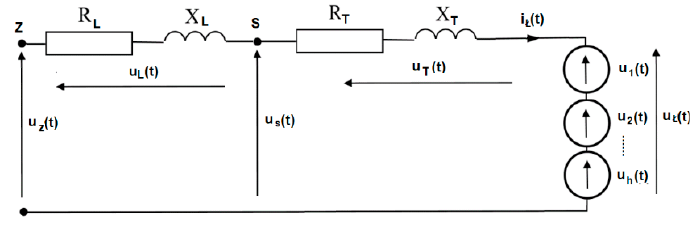
Figure 20. Single phase equivalent circuit with a multi-voltage arc model.